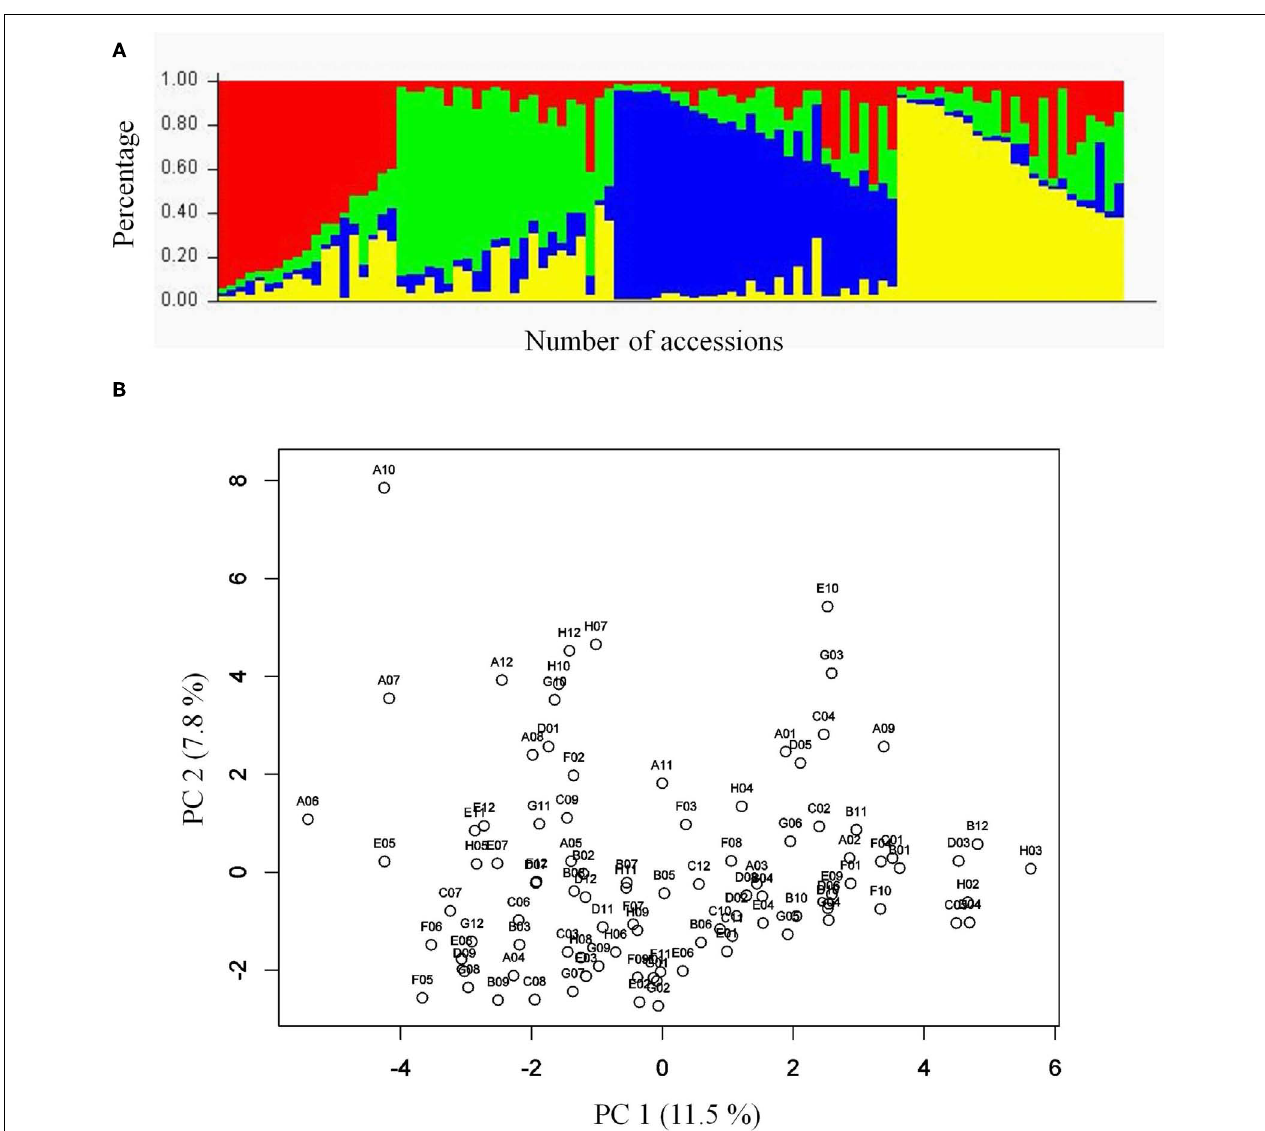
and numbers on the y -axis shows the group membership in percent. (B) Principal component analysis of panel 1 accessions based on 24 SSR markers. PC 1 and PC 2 refer to the first and second principal components. The numbers in parentheses refer to the proportion of variance explained by the principal